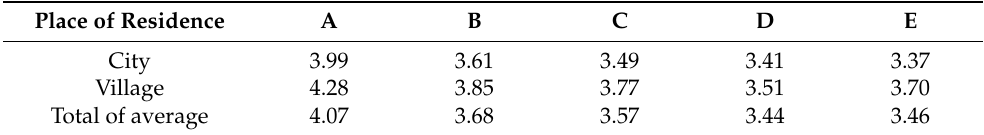
Table 3. Respondents’ opinions on Average of Necessity to transfer actions from the central to the local level.